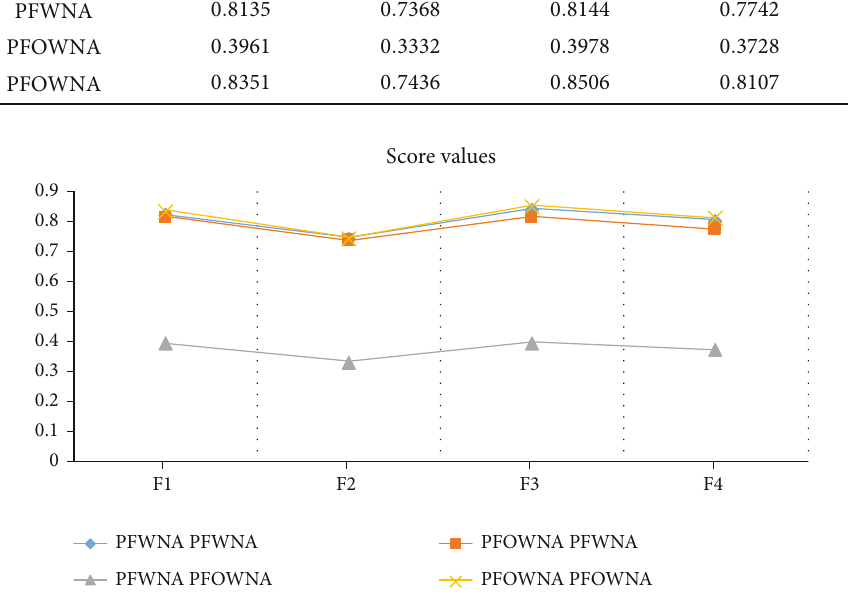
Figure 3: Geometrical interpretation of alteration of